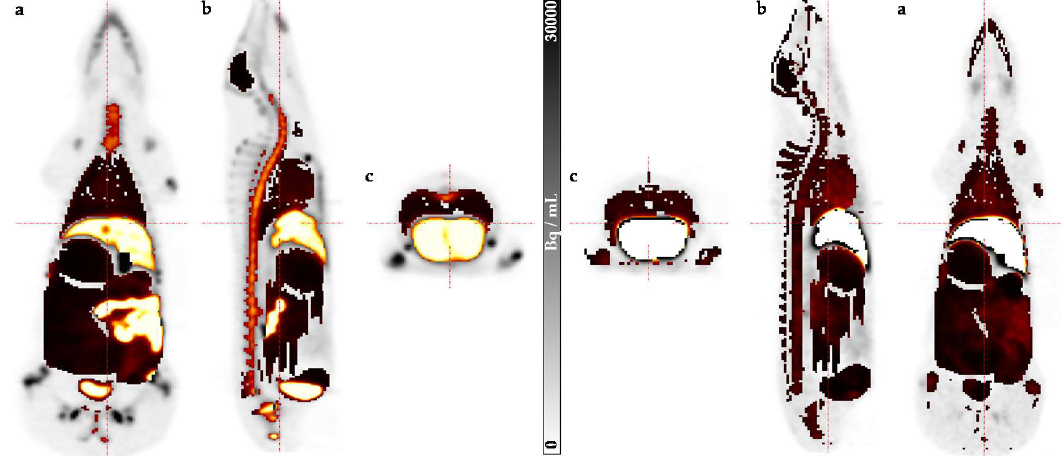
Figure 3. PET image with volumes of interest (VOIs) superimposed in ( a ) coronal, ( b ) sagittal, and ( c ) transversal views. The left panel, pig 1, obtained at 42 min post injection (p.i.), shows the organs except for the peripheral bone, whereas the right panel, pig 2, obtained at 56 min. p.i., shows all delineated organs. (The gray scale in the middle refers to the original quantitative PET data, not to the colored VOI structures).